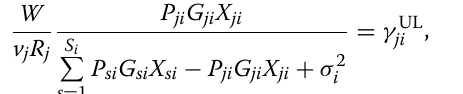
characterized by an average value 1 /μ d [s]. Both (cid:2) d and μ d can be different for UL and DL. connections are time varying functions: (cid:2) v ( h ) and (cid:2) d ( h )